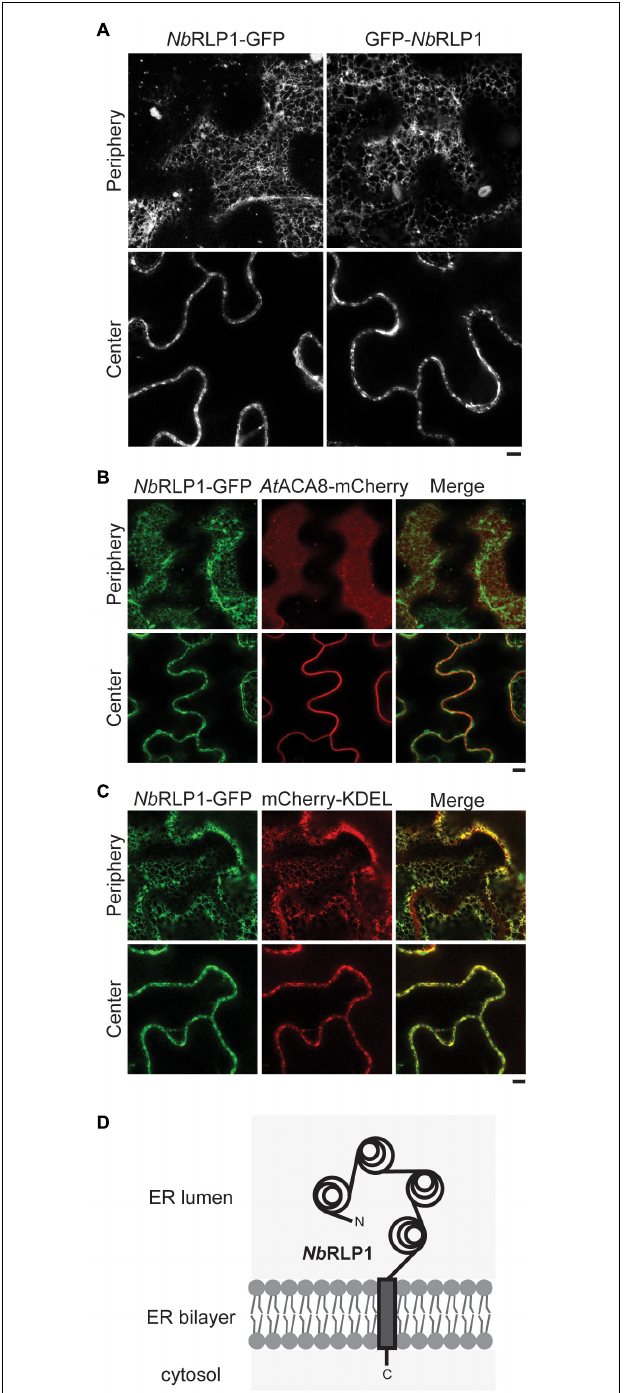
FIGURE 2 | Nb RLP1-GFP resides in the endoplasmic reticulum (ER) membrane. (A) Still images of Nb RLP1-GFP or GFP- Nb RLP1 taken from the periphery or the center of the same Nicotiana benthamiana leaves by Zeiss LSM880 confocal microscope. Scale bar, 5 µ m. (B) Same as A, except that Nb RLP1-GFP and At ACA8-mCherry are coexpressed in plants and imaged. Also shown are the corresponding merged images. (C) Same as B, except that Nb RLP1-GFP and mCherry-KDEL are coexpressed in plants and imaged. (D) A scheme depicting Nb RLP1 topology in the ER based on